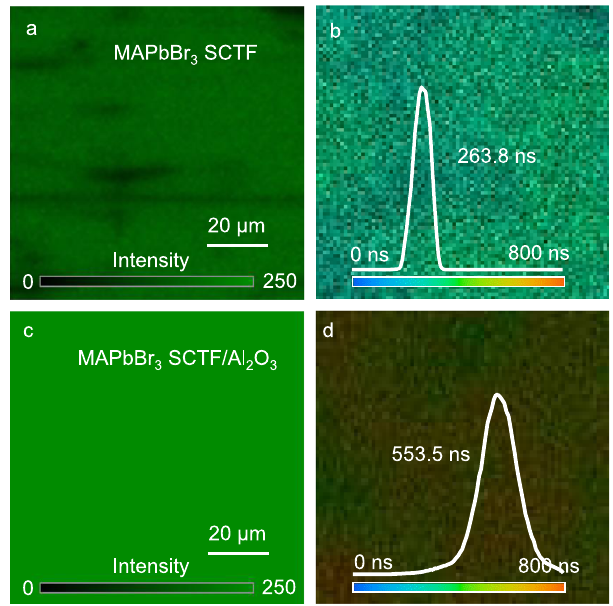
Fig. 3 Fluorescence spectroscopic measurements. Confocal fl uorescence intensity images (left) and fl uorescence lifetime imaging microscopy (FLIM) images (right) of pristine MAPbBr 3 SCTF ( a , b ) and MAPbBr 3 SCTF/ Al 2 O 3 ( c , d ).